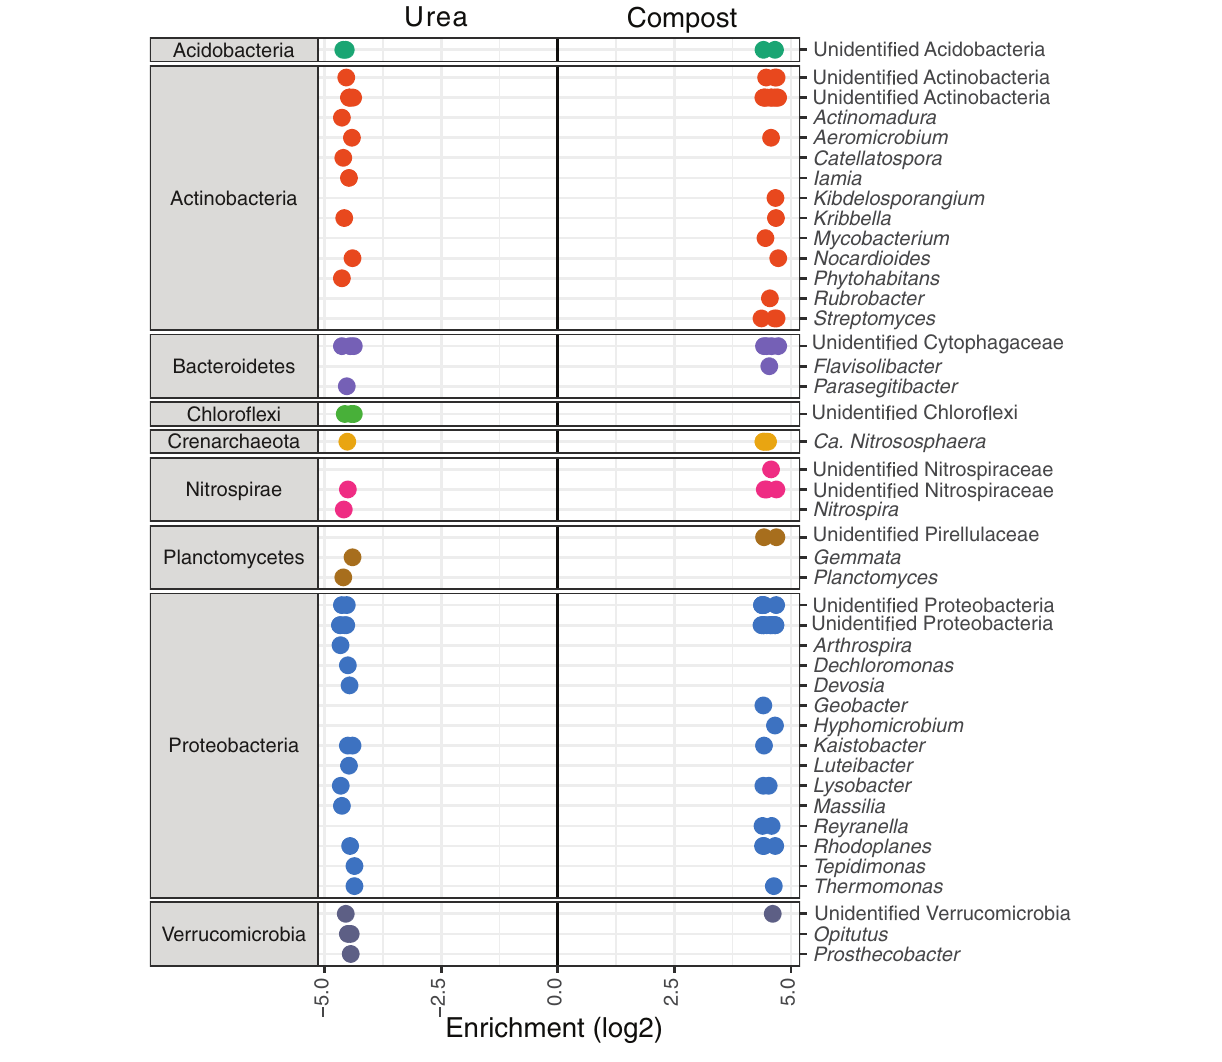
FIGURE 4 | Significant increases in relative abundance of bacterial OTUs in urea and compost-fertilized soils at crop cycle 1. OTUs are grouped by Phylum and identified to genus when possible. Each genus may contain multiple OTUs, represented by each dot on the line. When a genus cannot be identified although they were classified as different genera based on sequence homology, the identity of the most positively identified taxonomic level is provided (e.g., Actinobacteria ). Positive log 2 fold changes indicate preferences toward compost and negative log 2 fold changes indicate preferences toward